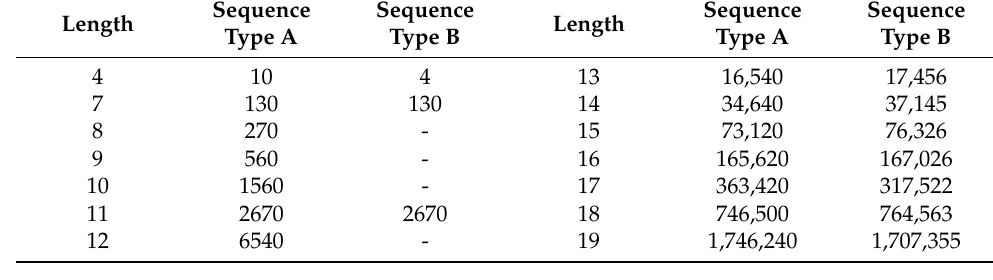
Table 1. List of optional parameter sequences.